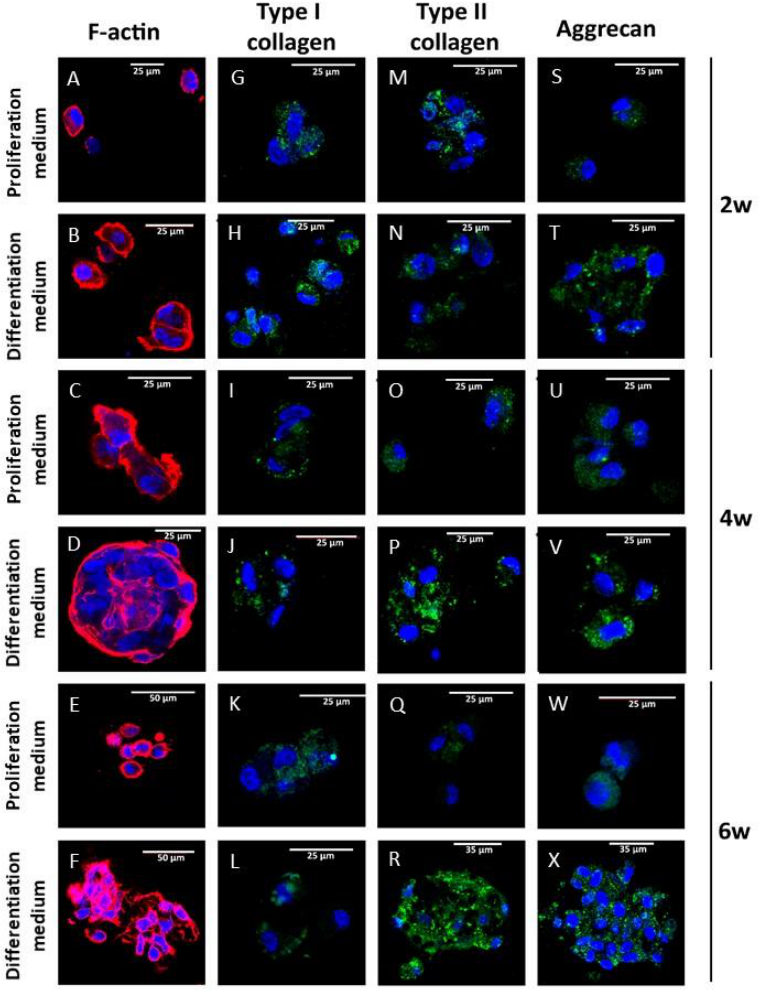
Figure 6. Chondral differentiation in alginate-agarose gels. Human primary chondrocytes were encapsulated in 3% algi- nate-1% agarose hydrogels and cultured with proliferation or differentiation medium for 2, 4 and 6 weeks at a density of 2 × 10 6 cells/ml. F-actin organization was evaluated by fluorescence microscopy using rhodamine-phalloidine ( A – F ). Type I ( G – L ) and type II ( M – R ) collagen as well as aggrecan ( S – X ) were evaluated by immunofluorescence. Nuclei were stained with DAPI. The images are representative of n = 5 different experiments. Type I and II collagen as well as aggrecan were determined by immunofluorescence staining in the same experimental groups. A residual expression of type I collagen was detected in all the experimental groups analyzed, being slightly higher in cells cultured